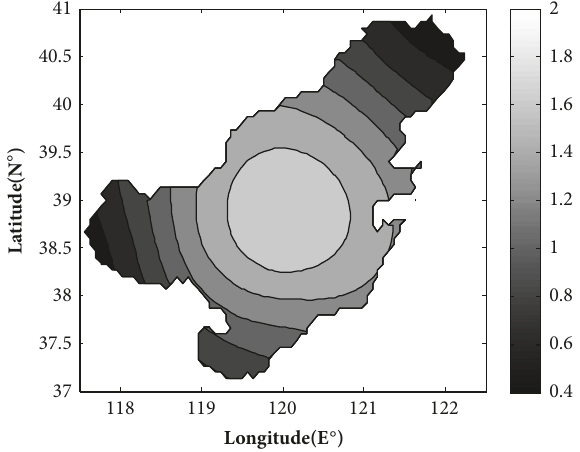
𝐽/𝐽 × 10 −4 and the mean absolute error 1 decreases to 5.0118 (MAE) of observation points decreases by 98.27%, from 1.08499 mg/L to 0.01873 mg/L. When using CDS with a 24 −4 hours’ time step size, 𝐽/𝐽 1 is reduced to 6.1274 × 10 and the MAE of observation points decreases by 98.20%. The inversion result of the adjoint model obtained by the CDS is inferior to that obtained by CFD with a large time step